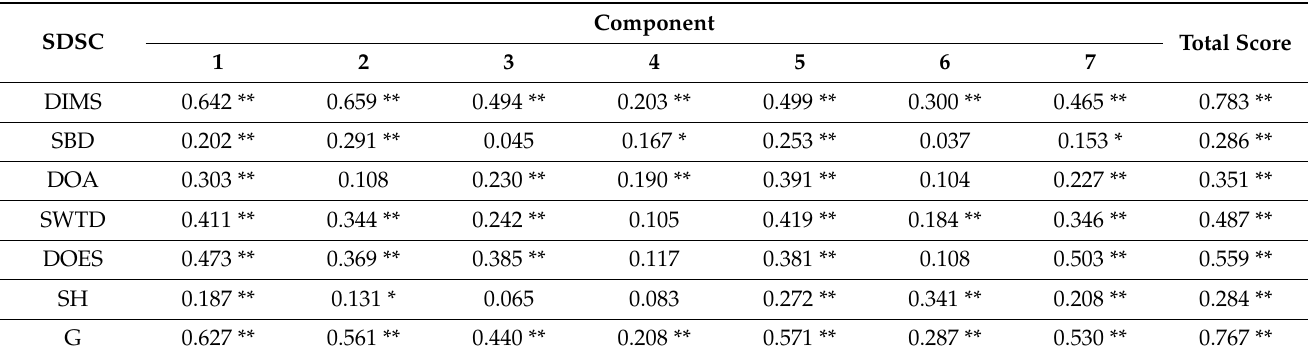
Table 3. Construct validity: Pearson’s correlation coefficient between the Sleep Disturbance Scale for Children (SDSC) and the Pittsburgh Sleep Quality Index